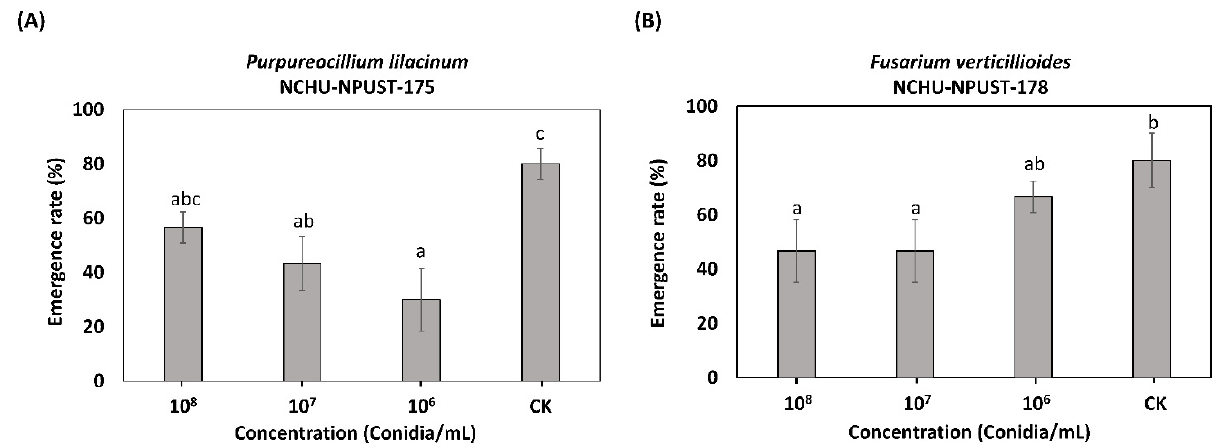
Figure 6. The emergence rate of F. taiwana after infection of ( A ) P. lilacinum PL-NCHU-NPUST-175 and ( B ) F. verticillioides FV-NCHU-NPUST-178 for 7 days. The different letters are significantly different at p ≤ 0.05 using Tukey’s test.